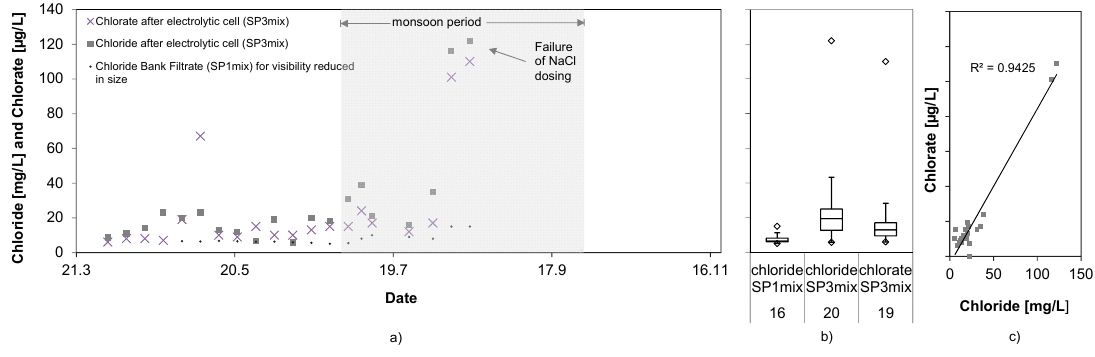
Figure 10. Chloride and chlorate concentrations during field test ( a , b ), and their correlation ( c ).